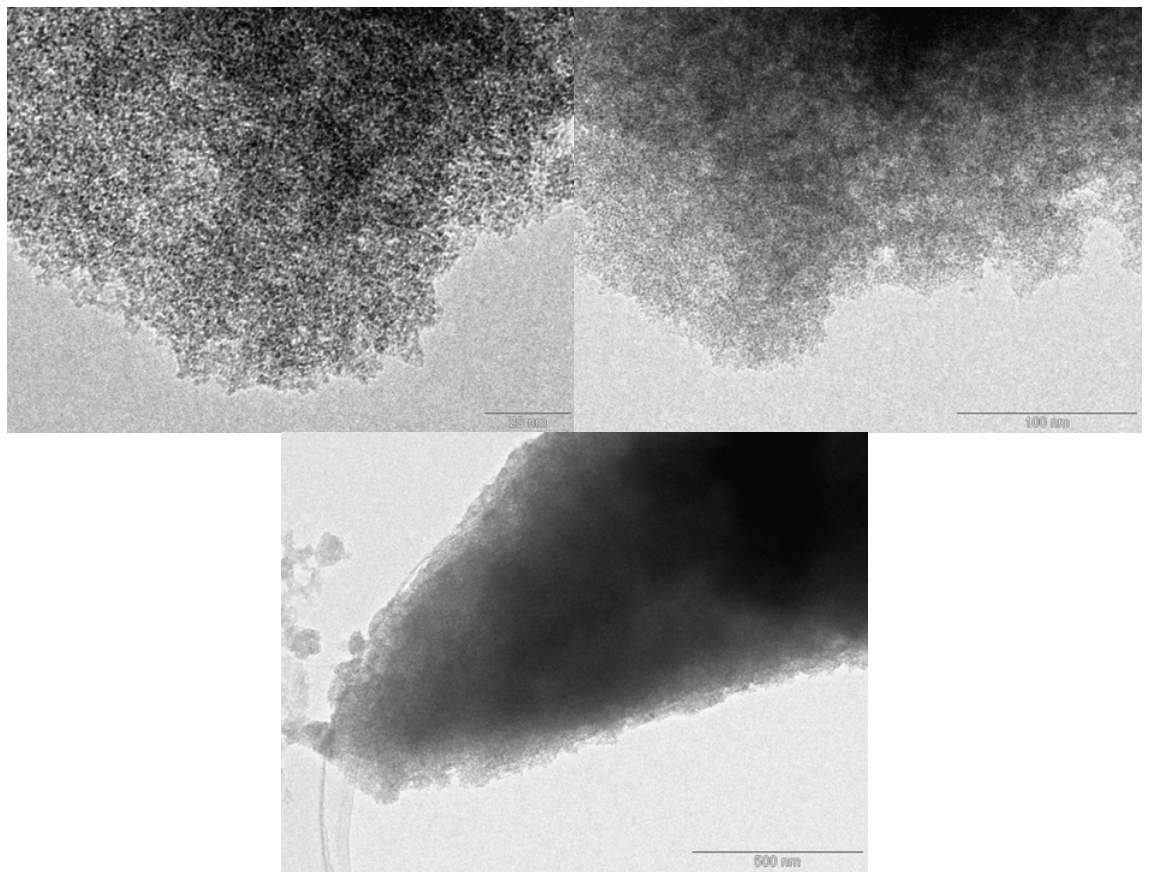
Figure 3. Transmission electron microscopy (TEM) micrographs of PT1-600